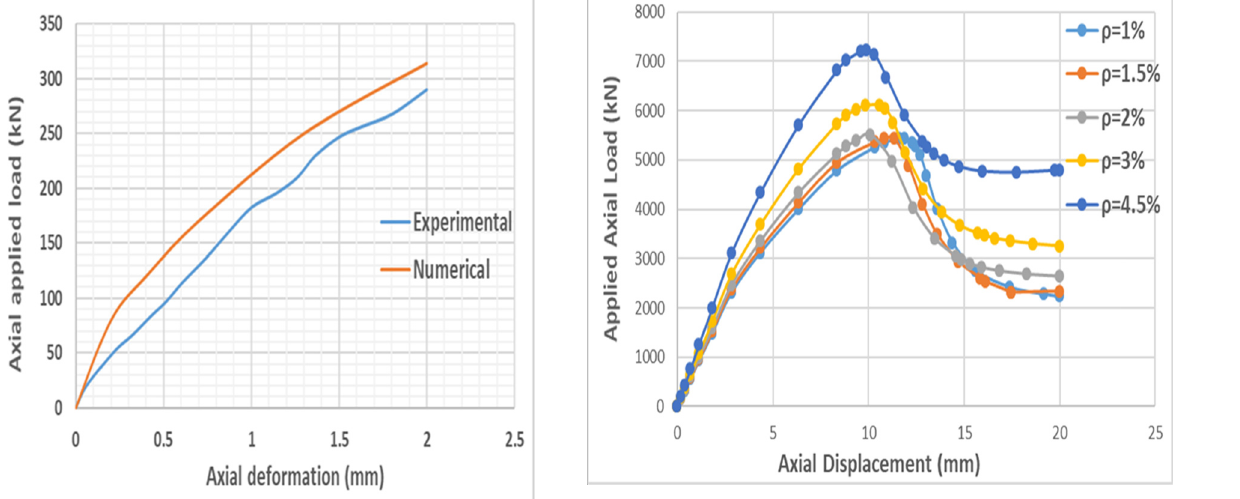
Figure 5: Load - vertical displacement C2 ( burned with a fi re fl ame of 300°C ) [ 20 ] .